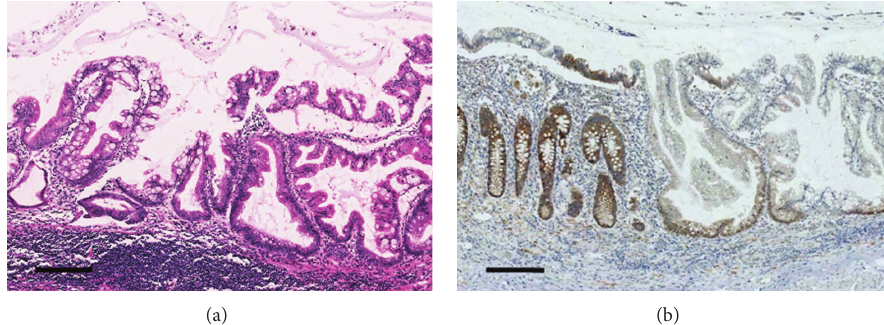
Figure 2: (a) SSL in the root of the appendix. (b) SSL is regionally observed in the right half of the epithelium, while nondysplastic epithelium can be observed in the left half. SSL shows the loss of hMLH-1 expression; however, a weak to moderate reactivity is preserved in the deep part of the crypts. A hMLH-1 positive control was evaluated on nondysplastic epithelium. The scale bars indicate 250 micrometers.